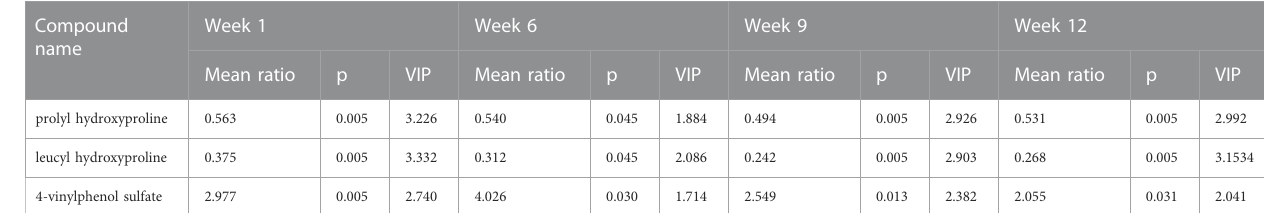
TABLE 1 Intersections of differential metabolites (ZA versus